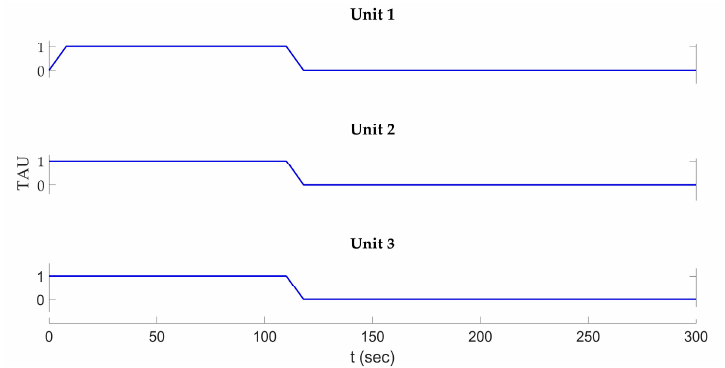
Figure 2. Valve opening for case b.